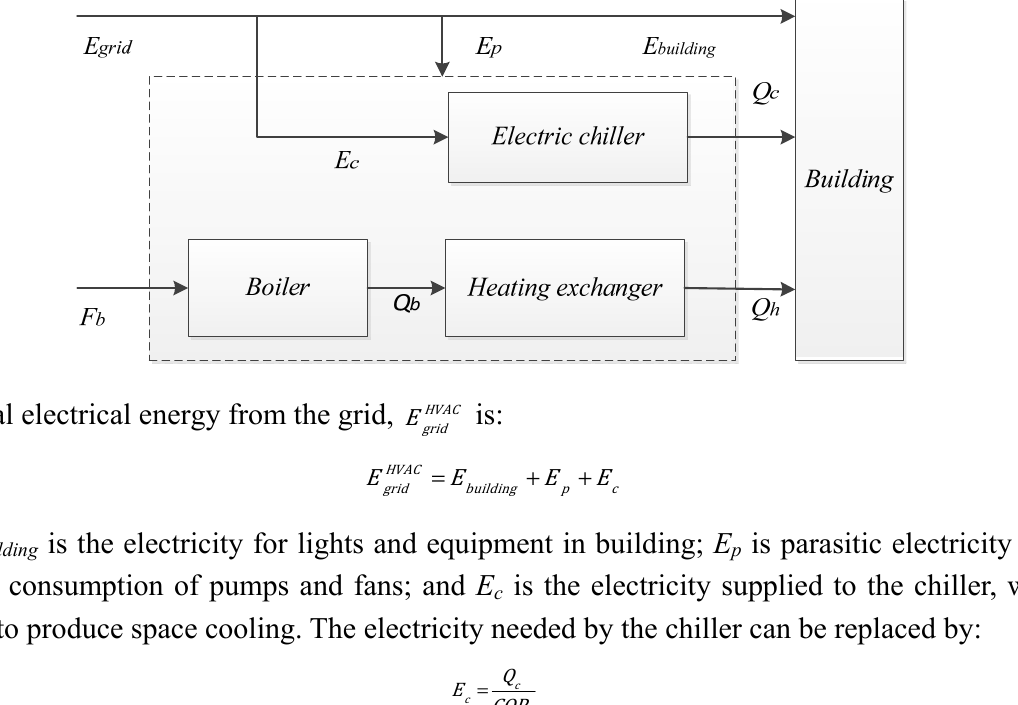
Figure 1. General separated production system layout for building and energy